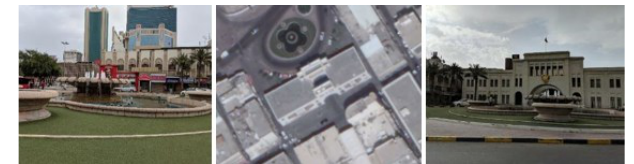
Figure 11. Water fountain